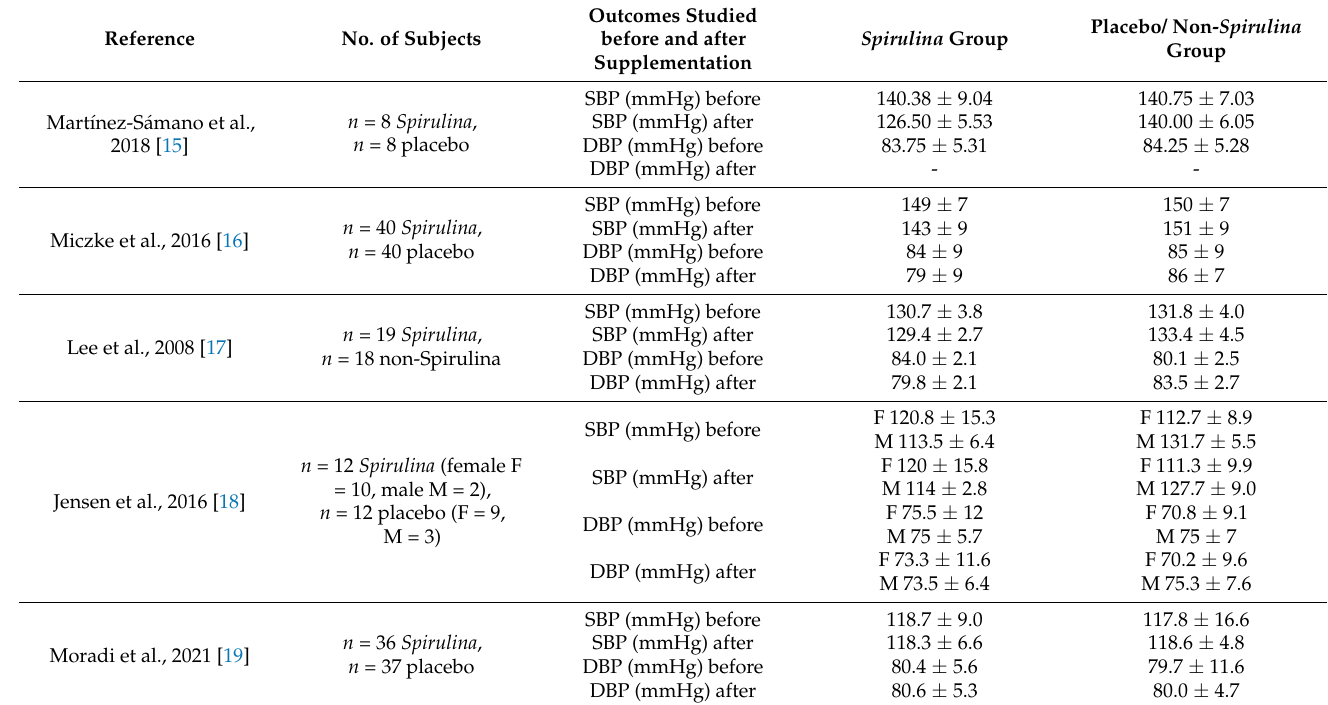
Table 3. Detailed parameters of systolic blood pressure (SBP) and diastolic blood pressure (DBP) from the included randomized controlled trials